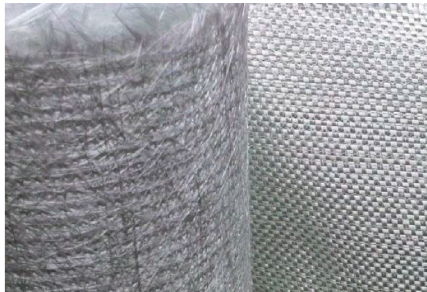
Figure 5: Woven roving Combi mat laminated